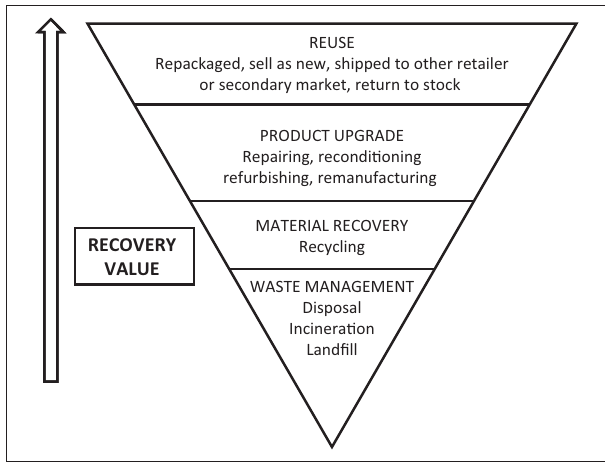
FIGURE 2: Disposition options and recovery